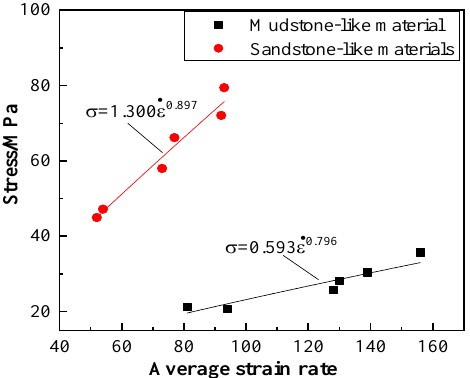
Figure 8. Relationship between dynamic strength and strain rate of similar materials.